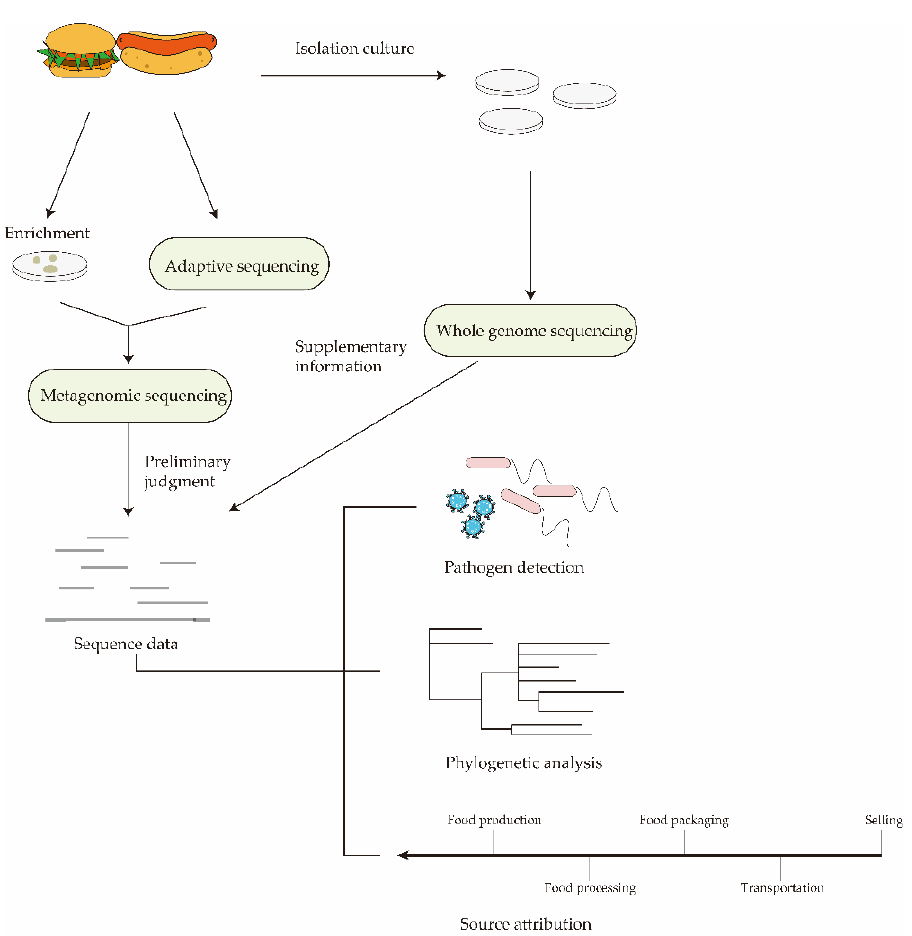
Figure 4. Schematic diagram of an ideal real-time monitoring and traceability system. In the early stages of a foodborne pathogen outbreak, the pathogen can be inferred based on the clinical symptoms of the infected individuals. The associated foodborne pathogens are then selectively enriched from food, or target sequences are enriched directly by adaptive sequencing. Finally, the enriched microorganisms or sequences are subjected to nanopore sequencing. Sequence data generated by sequencing can be used for pathogen detection, phylogenetic analysis, and source attribution. If the amount of data is insufficient, perform WGS after isolation and culture of foodborne pathogens in food. The resulting detailed sequence data can complement the results of metagenomic